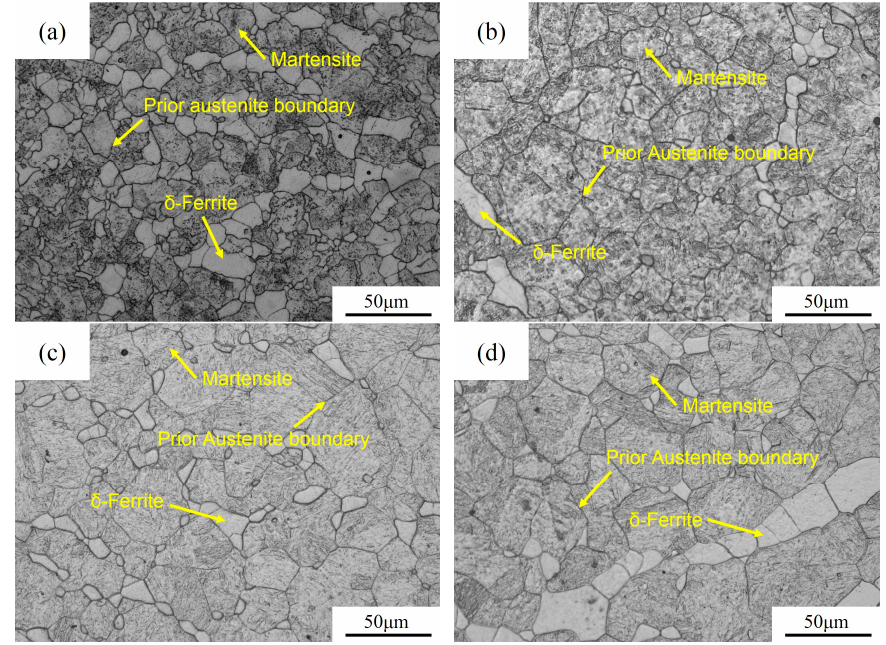
Figure 2. Optical micrographs showing the prior austenite grain boundaries, holding at: ( a ) 900 °C; ( b ) 1000 °C; ( c ) 1100 °C; and ( d ) 1200 °C for 400 s.